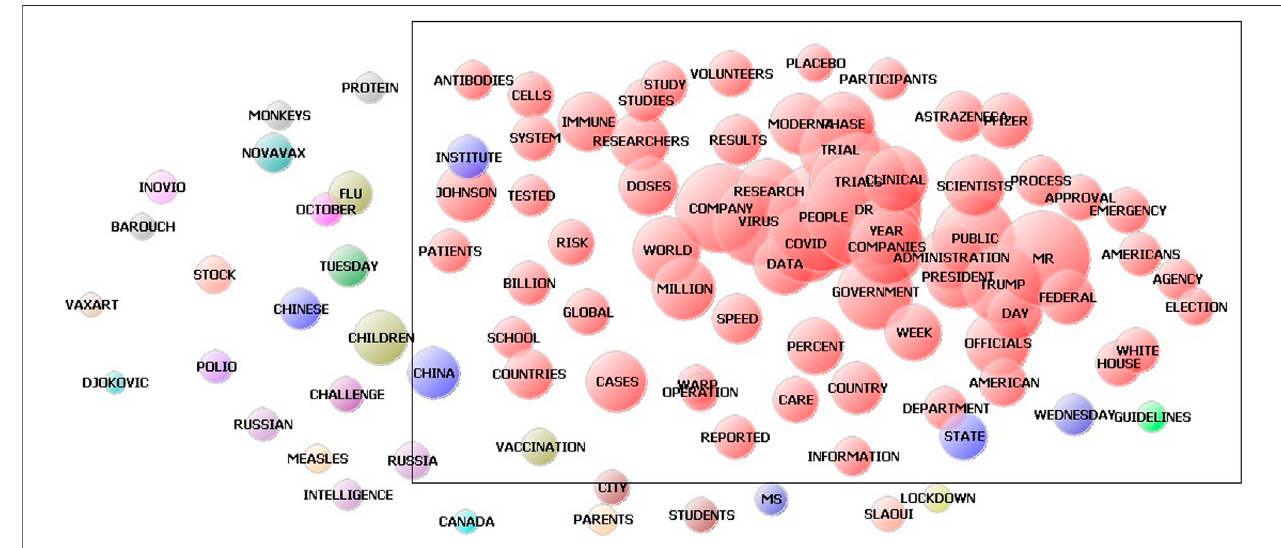
FIGURE 2 | Conceptual map with clustering of The New York Times .